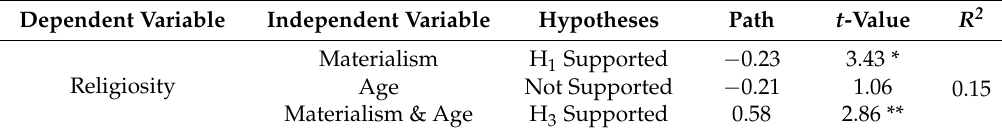
Table 6. Results of the structural